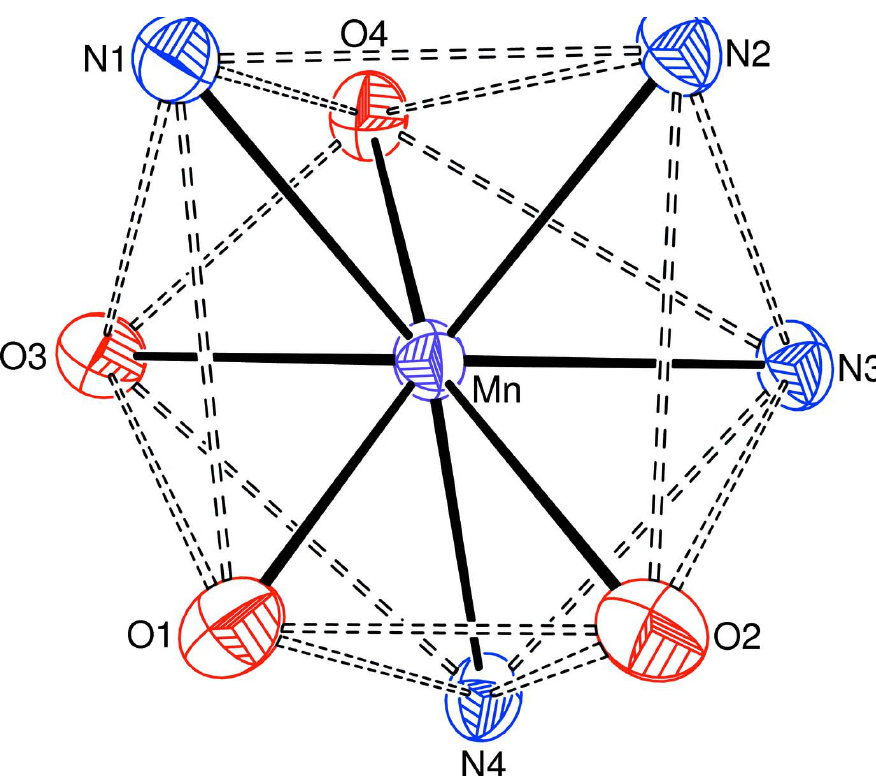
Figure 2 View of the distorted square antiprismatic geometry around the eight-coordinated Mn atom. Dashed lines (no bonds) are used for the clear representation of the